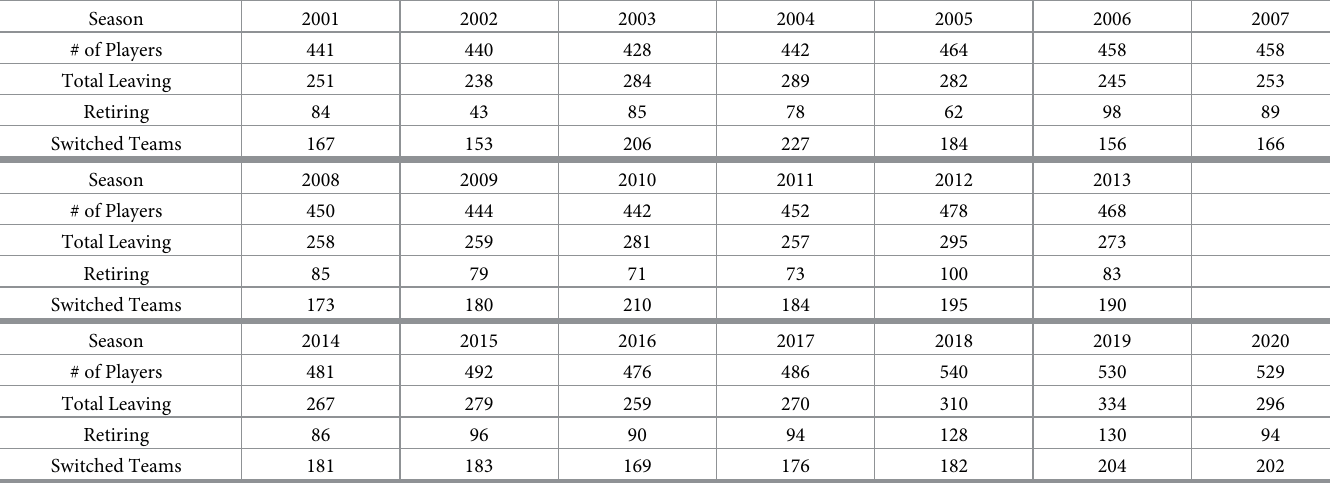
Table 4. The number of National Basketball Association (NBA) players per year comprising the 2001–2020 seasons. We note that there are approximately half the number of players in this dataset compared to the baseball dataset. Also, a higher percentage of players transition annually in the NBA (on average about 58%). A high amount of players switch teams each year, about 67%, while only 32%